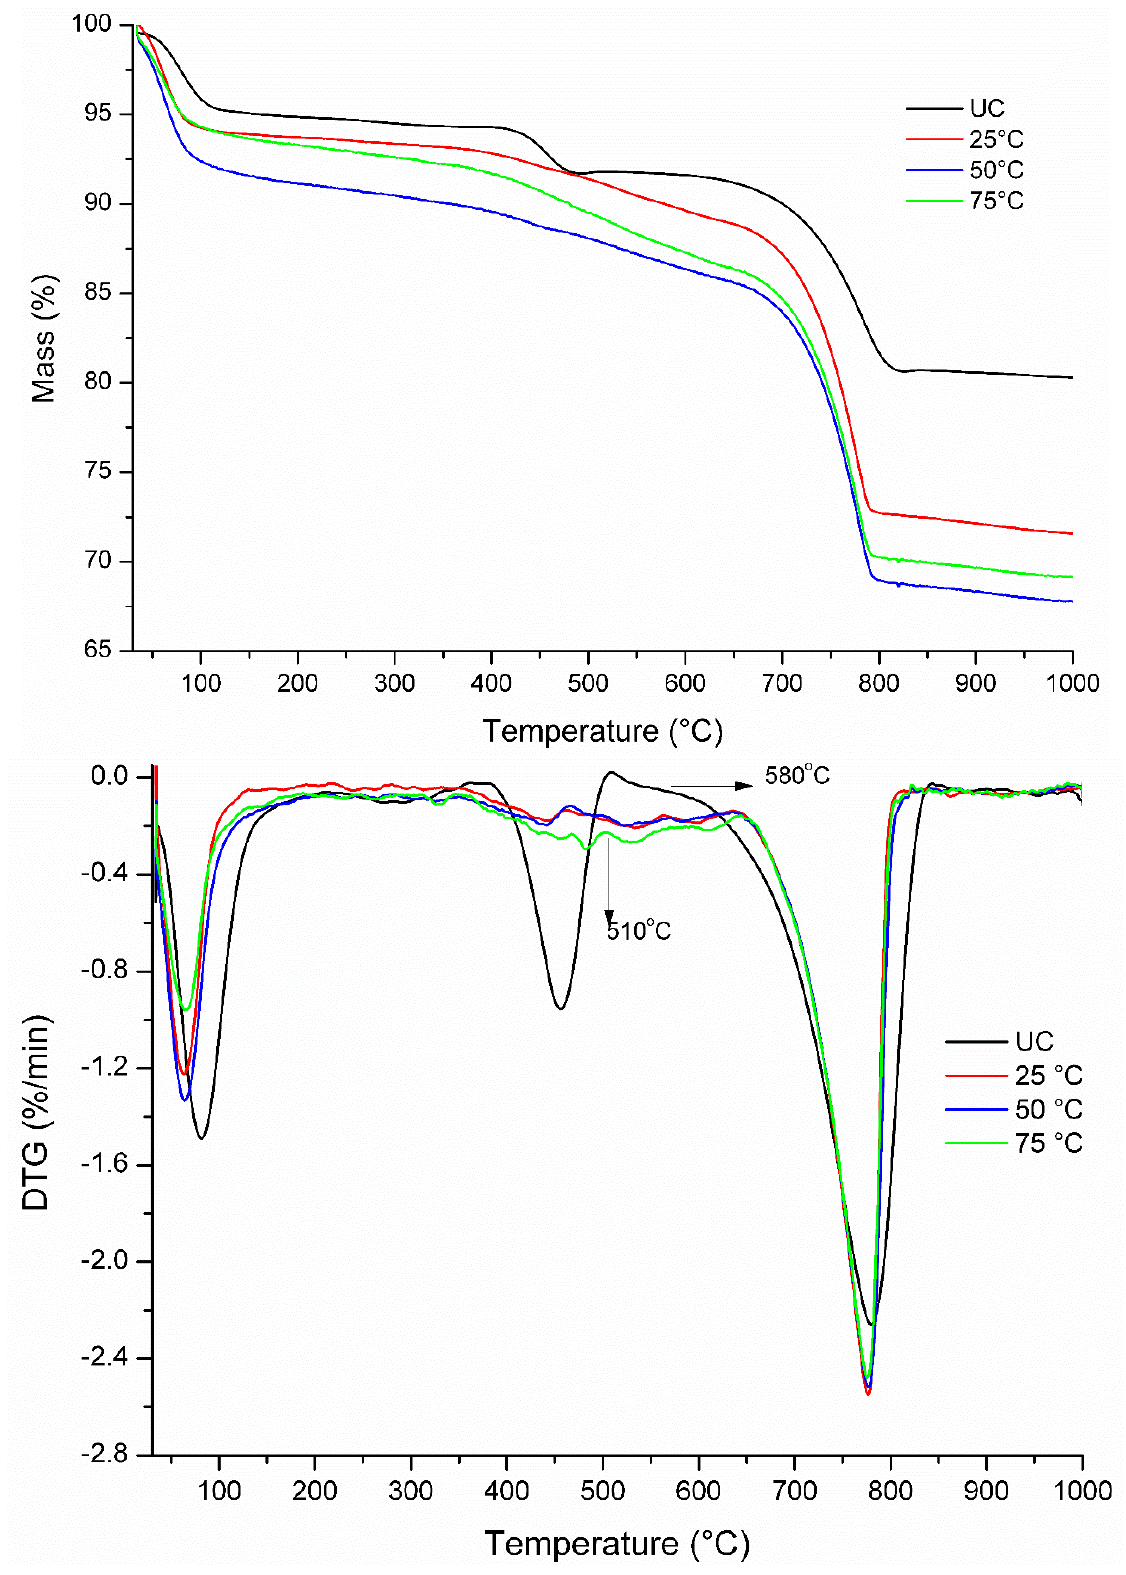
Figure 14. TGA and DTG of WA compacts that are uncarbonated (UC) and cured at 25 °C, 50 °C, and 75 °C. and 75 ◦